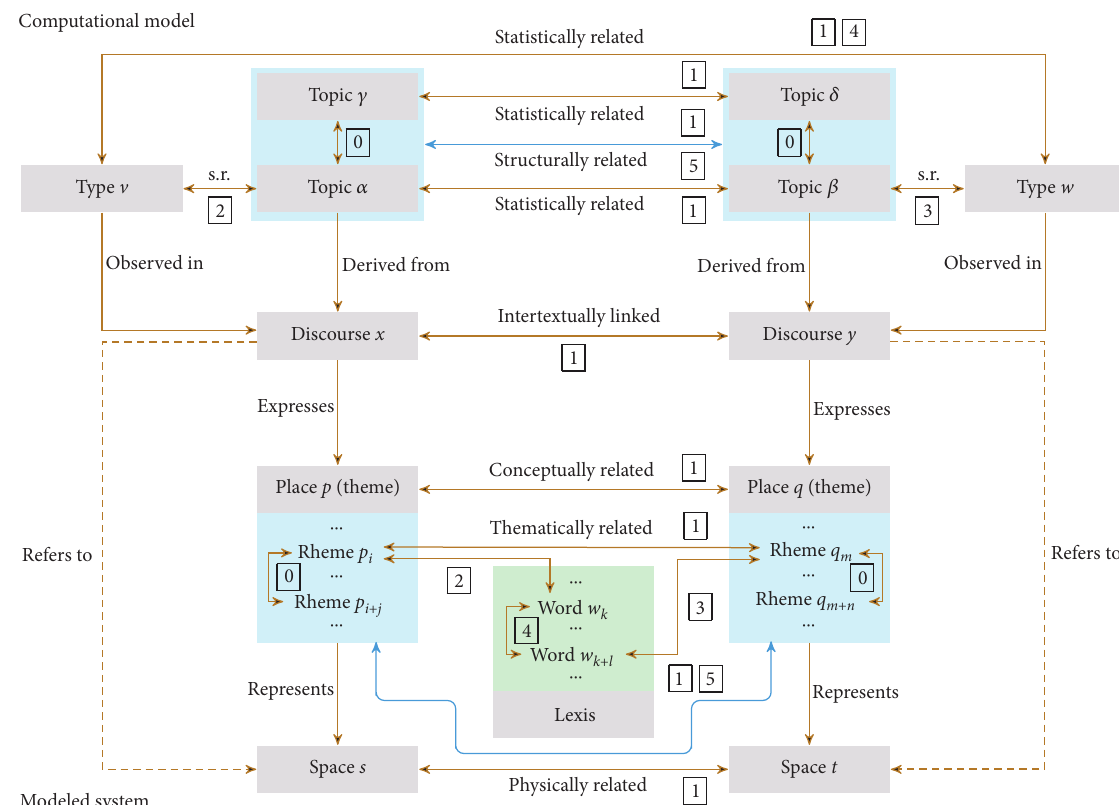
Figure 1: Schematic depiction of a generalization of a hypothesis of Louwerse and Zwaan [16] saying that language encodes geographical information: the places p and q are expressed in the discourses x and y , respectively, from which the topic representations α and β are computationally derived. Places are structured into systems of networked rhemes or subtopics. The conceptual relatedness of p and q is grounded in the relatedness of the rhemes p i and q m and modeled by the relatedness of the derived topics α and β modeling these rhemes. According to the semiotic triangle, we assume that the relation of signs (here, texts) to their referents (here, spaces) is mediated by sign processes. We use dashed arcs to express the indirect relation of the former to the latter. In lexical variants of this approach, p and q are preferably denoted or described by some words w k and w k + l of the underlying lexis, which are syntagmatically or paradigmatically associated and modeled by some types v and w . Framed numbers indicate relations that potentially parallelize each other. s.r. means statistically related